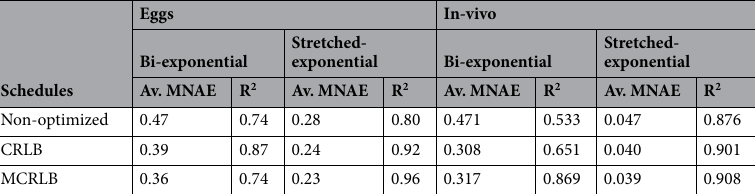
Table 3. Results for the egg yolk and in-vivo knee mapping. Average MNAE and R 2 values for the optimized schedules are better than those obtained with the Non-optimized schedules.